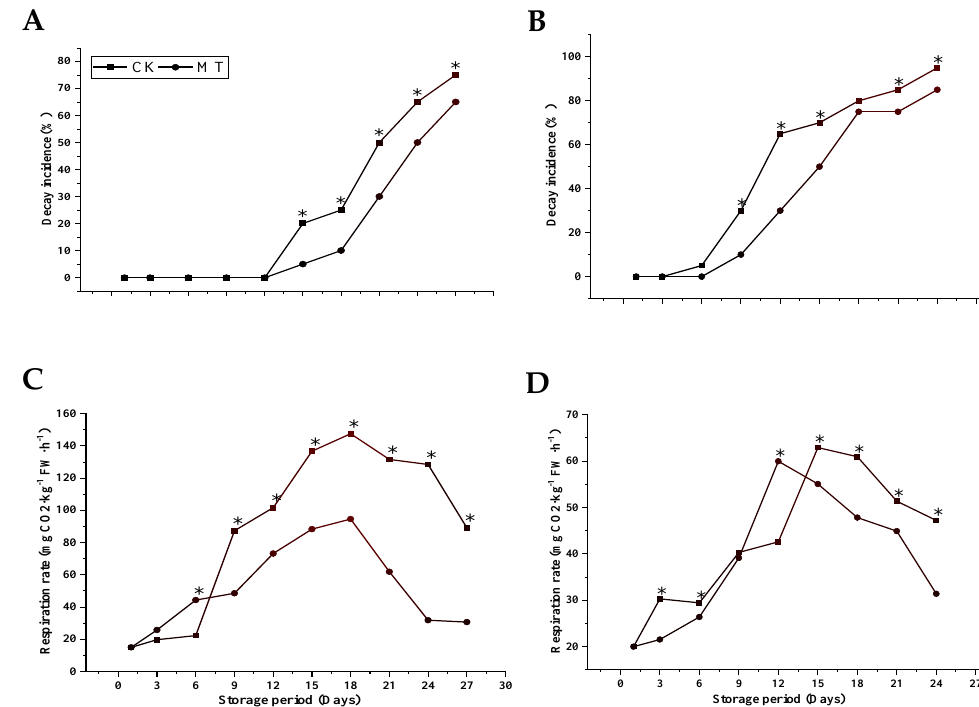
Figure 2. Decay incidence ( A , B ) and respiration rate ( C , D ) of ‘Guiqi’ ( A , C ) and ‘Tainong 1’ ( B , D ) fruits treated with 1000 μmol L −1 MT. Each value is the mean for three replicates, and vertical bars indicate the standard error (SE). Error bars with an asterisk (*) on the same storage period show a significant difference between the treatments ( p < 0.05).